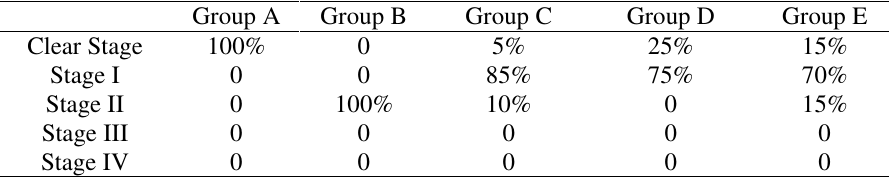
Table 2. Effect of Triphala ghrita on the onset of galactose-induced cataract in rats observed after 14 days